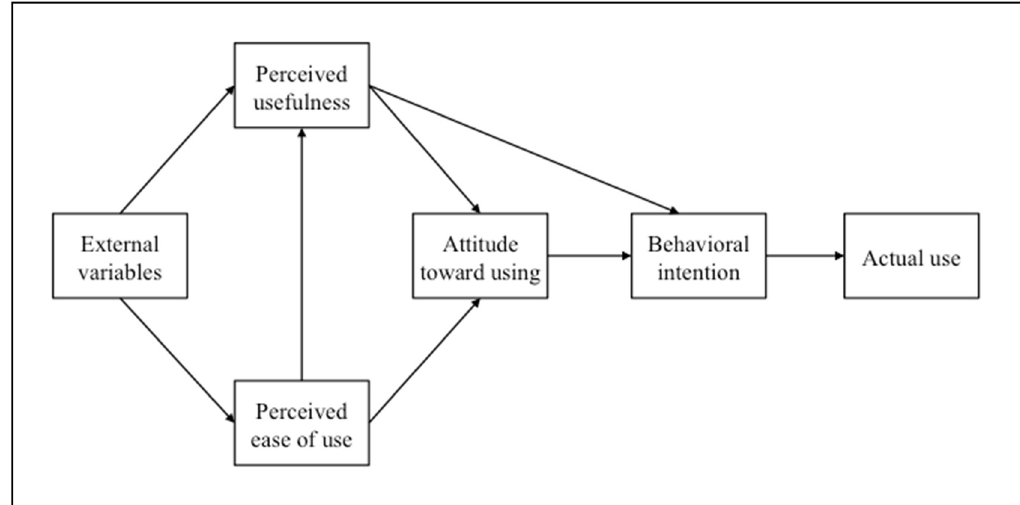
Figure 1. Original technology acceptance model (adapted from Davis et al. [11], p. 985). Table 1. Constructs of proposed technology acceptance model (TAM), definitions, and research hypotheses. Constructs